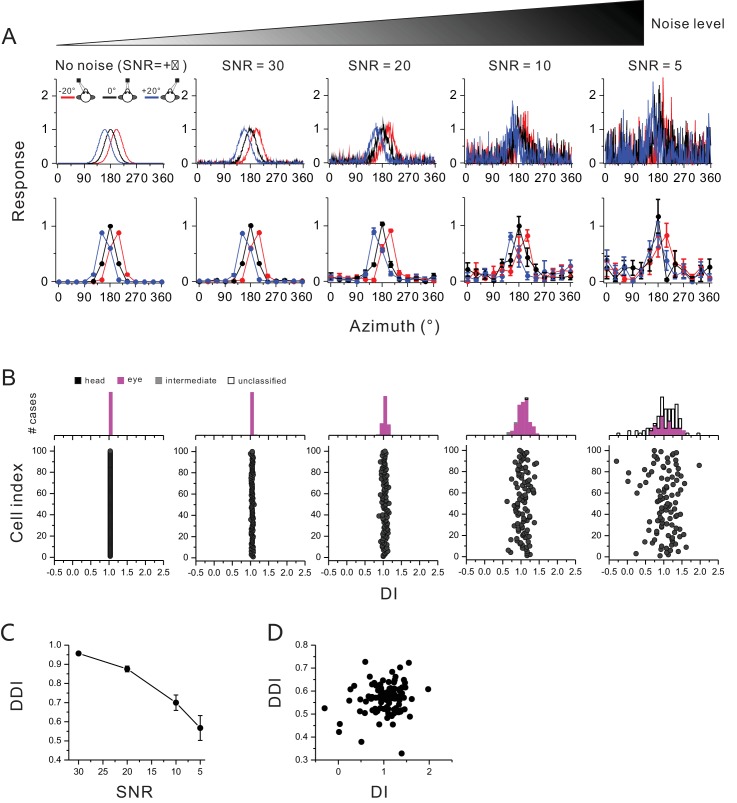
DI under different noise levels in hypothetical neurons.(A) All neurons were assumed to be completely eye-centered, that is tuning shifted by 20° under eccentric fixation protocol. These tuning curves were injected with different levels of noise by Matlab function ‘awgn’. The smaller the signal to noise ratio (SNR, from left to right), the noisier the tuning curve was. For example, the top panels exhibit one trial of the responses sampled at a resolution of 1°. We repeated this sampling for five times and computed the mean firing rate at each azimuth at a resolution of 12° as the tuning curve (bottom panels), a process of which was similar to the real neural recording experiment. Error bars are standard error of mean. (B) Under each noise level, a population of 100 cells was created, and DI was computed in the exact same way as for the real neurons. It is clear that when noise is getting larger in the tuning curves, the DI values tend to be more broadly distributed, generating some seemingly head-centered units. However, the number of these units is small, and importantly these units are statistically defined as ‘unclassified’ based on the bootstrap test procedure. (C) The strength of directional tuning was quantified using a direction discrimination index (DDI, Takahashi et al., 2007) given by: DDI=Rmax-RminRmax-Rmin+2SSE/(N-M). DDI not only computes the peak to trough modulation (Rmax-Rmin), but also the response variability (SSE: sum squared error around the mean response; N: total number of trials; M: total number of stimulus directions). DDI ranges within [0 1], corresponding to weak and strong SNR, respectively. (D) DI is not significantly dependent on DDI (R = 0.11, p=0.3, Spearman rank correlation) for hypothetical neurons tested under SRN = 5.